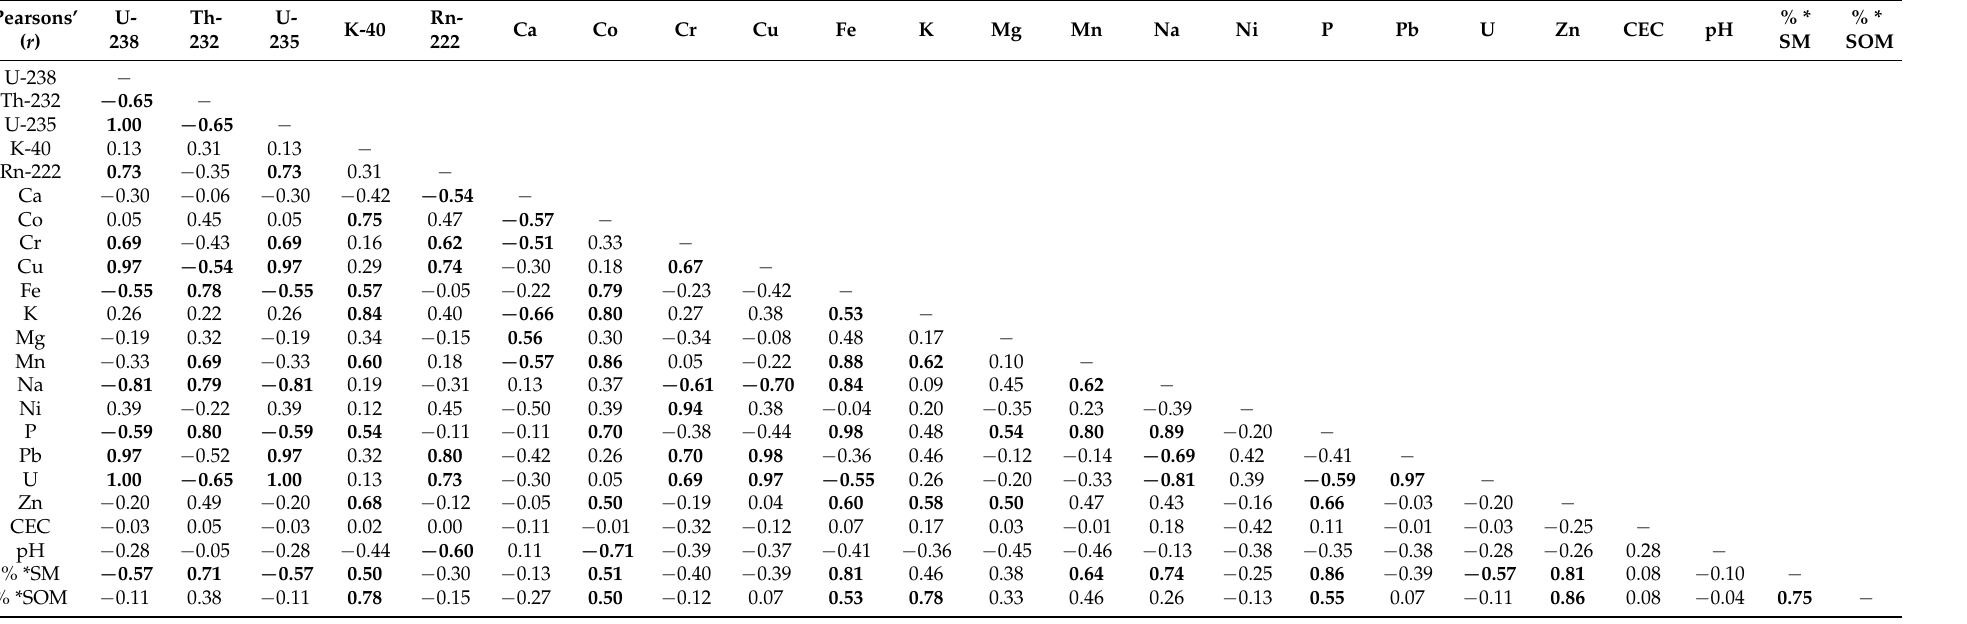
Table A2. The correlation matrix ( r ) for the concentrations of the natural radionuclides, total PTEs, and the chemical properties of the